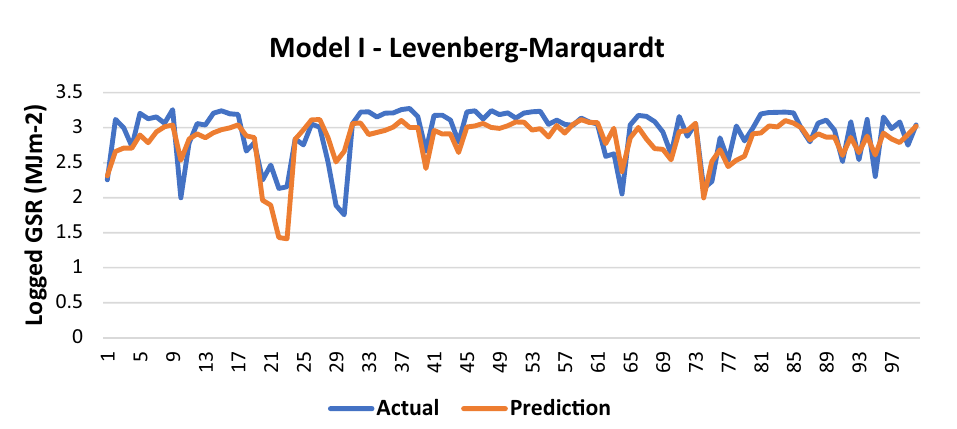
Figure 3. Graph of Actual and Predicted GSR (Model I—LM).